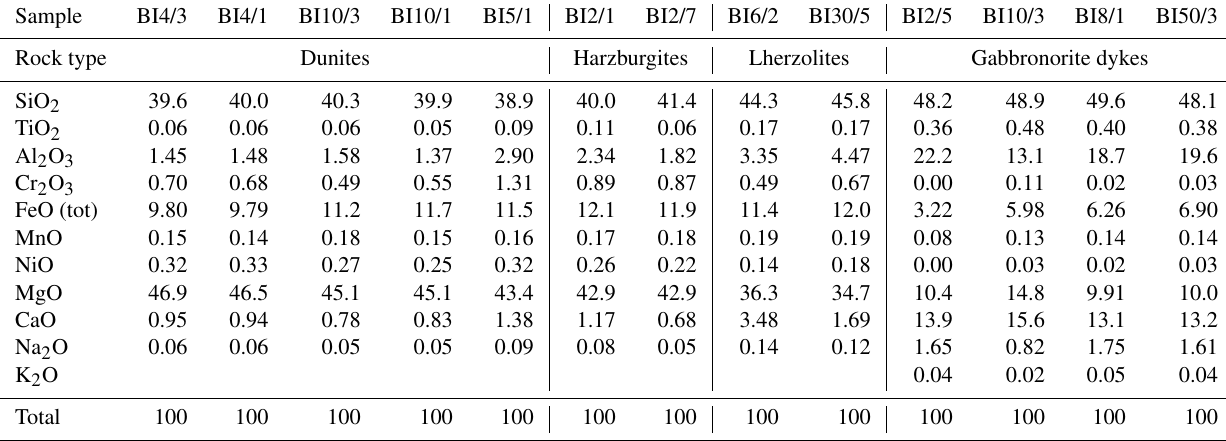
Table A1. Computed whole-rock chemical compositions of selected samples resulting from mass balance calculations, based on observed mineral compositions (Tables 2–7) and estimated mineral proportions (Table 9).